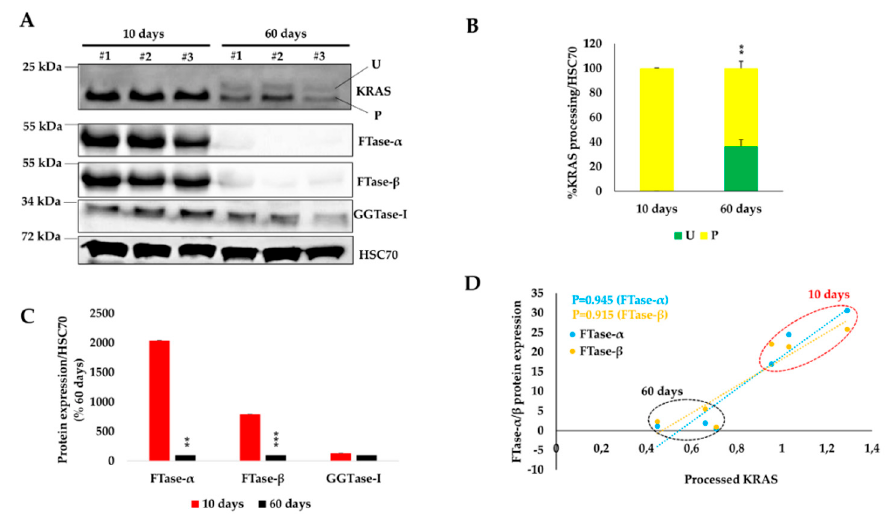
Figure 7. KRAS prenylation status in young and adult pancreata. ( A ) Western blot analysis on total pancreas lysates from young (10 days, n = 3) and adult mice (60 days, n = 3). ( B ) Densitometry quantification, from panel A, of unprenylated (green) and prenylated (yellow) KRAS forms normalized to HSC70, which is used as a loading control. ( C ) Densitometry quantification from panel A for FTase- α and - β , and GGTase-I. ( D ) Pearson’s correlation between prenylated KRAS form and the expression levels of FTase- α and - β in young and adult pancreata; densitometry values were used from blots shown in panel A. U: unprenylated; P: prenylated. Data are mean ± SEM. Statistical significance was tested using student’s t -test (**: p < 0.01; ***: p <